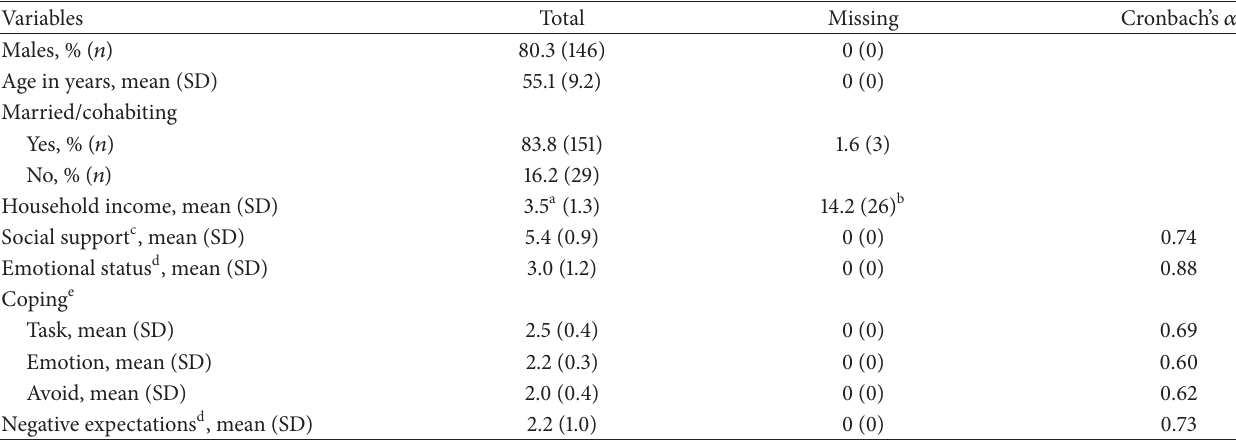
Table 1: Baseline data on 183 patients with valid six-month data participating in a four-week cardiac rehabilitation programme at Krokeide Rehabilitation Centre, Bergen, Norway, from 2000 to 2002. Variables Total Missing Cronbach’s 𝛼